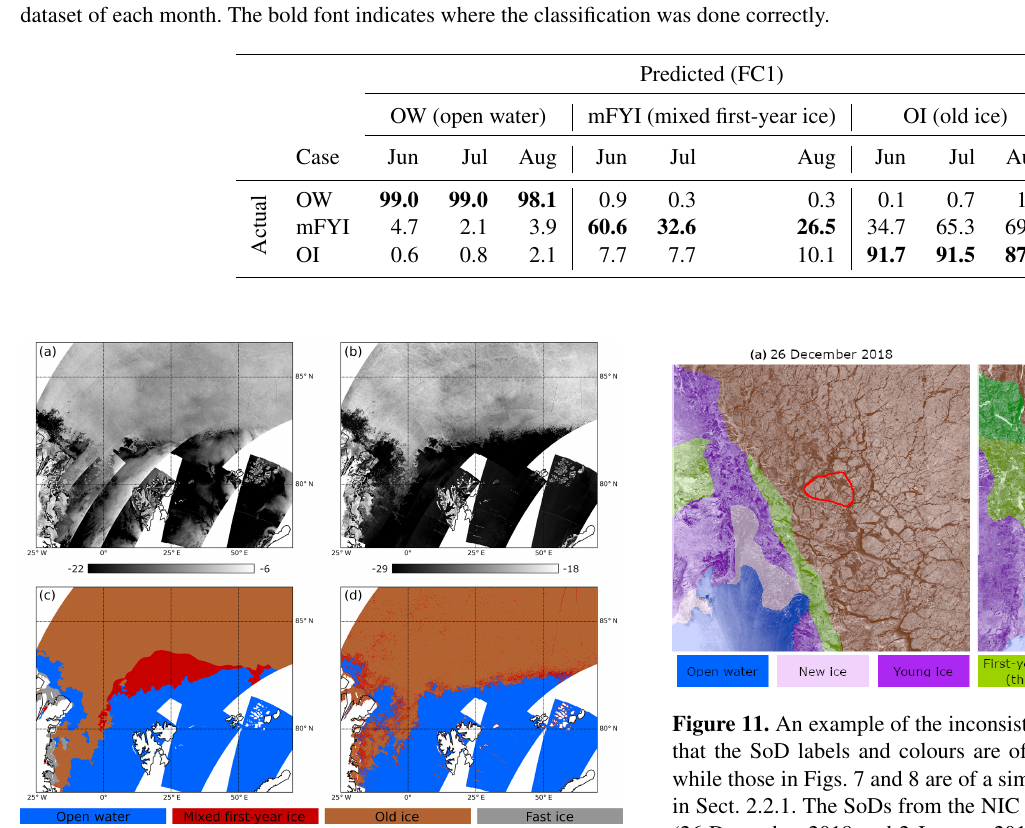
Figure 10. The 1d mosaics of Sentinel-1A/1B images ( a : HH; b : HV) and the ice classification result (d) on 16 August 2018. The publication date of the reference weekly ice chart (c) is 16 Au- gust 2018.